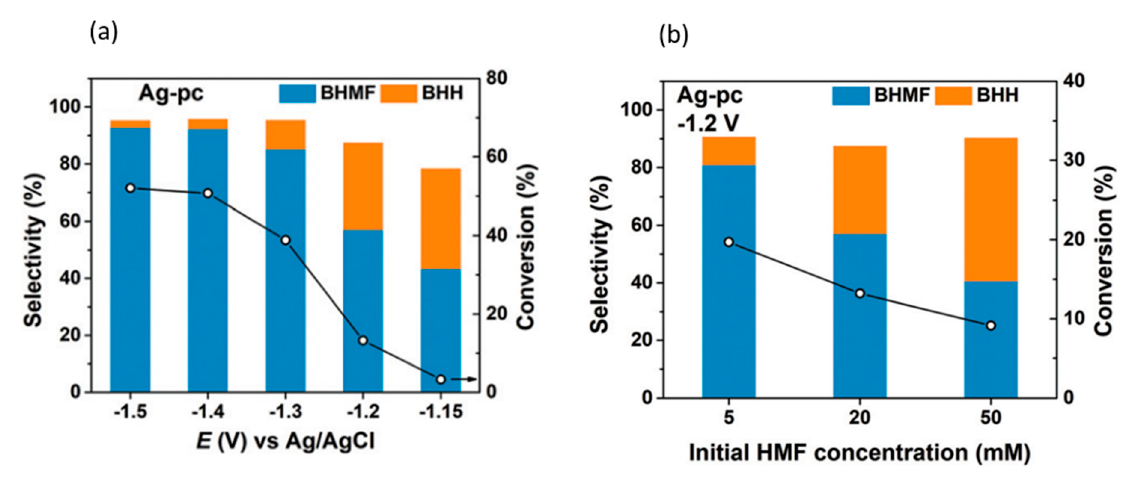
Figure 17. ( a ) Product selectivities at different cathodic potentials (vs. Ag/AgCl). ( b ) Product selectivities at different 5-HMF concentrations. Reprinted with permission from Ref. [96]. Copyright 2019, Green Chemistry.